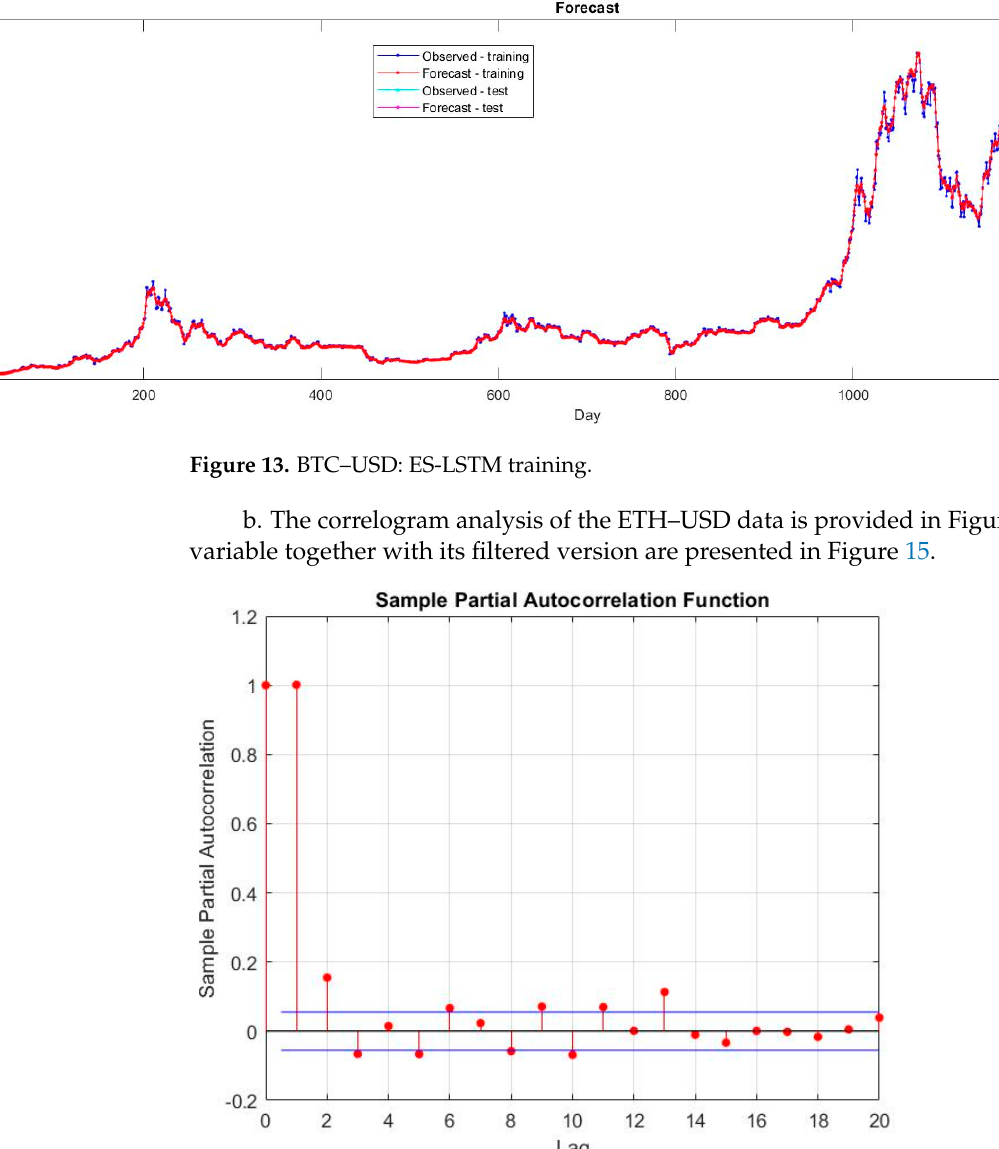
Figure 12. BTC–USD: LSTM–ADAM optimizer training.